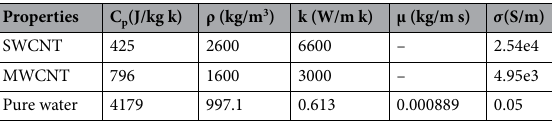
Table 1. CNTs thermal properties 1 .